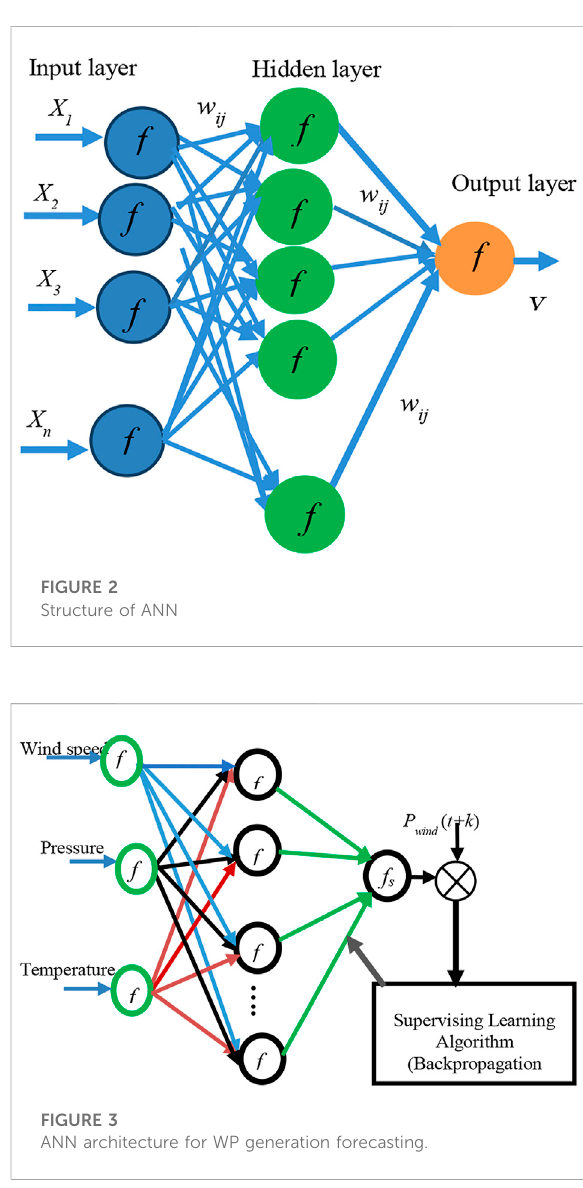
FIGURE 3 ANN architecture for WP generation